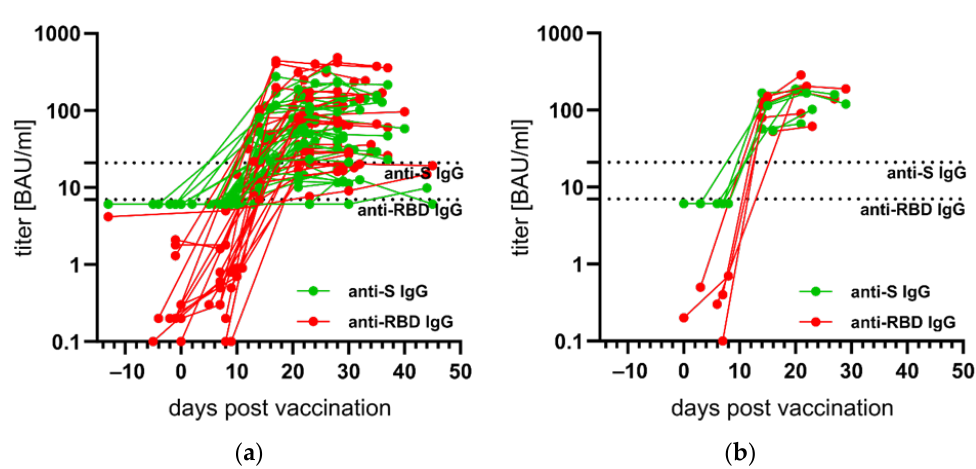
Figure 2. Kinetics of anti-spike (S)- and anti-receptor-binding domain (RBD) immunoglobulin G (IgG) in days before or after the first vaccination with the vector vaccine AZD1222 (( a ); follow-up samples from 40 vaccinees) and with the messenger ribonucleic acid vaccine BNT162b2 (( b ); follow- up samples from six vaccinees). All titers were measured in Binding Antibody Units per milliliter (BAU/mL). Connecting lines show the course of the measured values for individual vaccinated persons. The cut-off values for seropositivity (in BAU/mL) of the anti-S- and anti-RBD IgG assays are indicated by dotted lines.